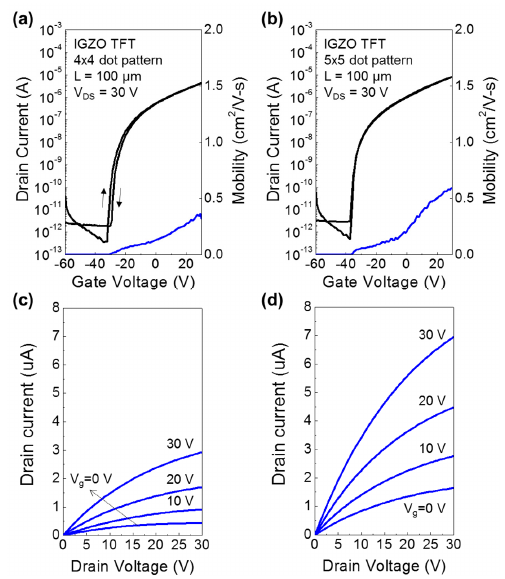
Figure 3. Transfer characteristics of IGZO TFTs inkjet-printed with ( a ) 4 × 4, and ( b ) 5 × 5 dot array printing patterns. Output curves of IGZO TFTs inkjet-printed with ( c ) 4 × 4, and ( d ) 5 × 5 dot array printing patterns.